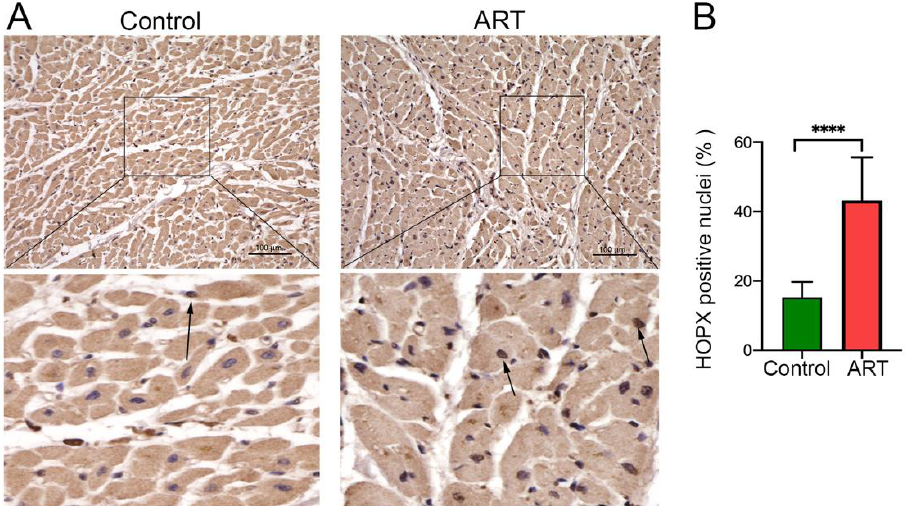
Figure 3. ARVs induce the accumulation of HOPX protein in the nucleus of cardiomyocytes. ( A ) Immunohistochemistry was performed in human heart tissue of HIV patients (n = 7) and healthy controls (n = 8) using HOPX antibody. The brown color represents the HOPX staining. ( B ) Graph showing percentage of brown HOPX nucleus distribution in cardiomyocytes compared to healthy controls ( p -value ****, <0.0001).